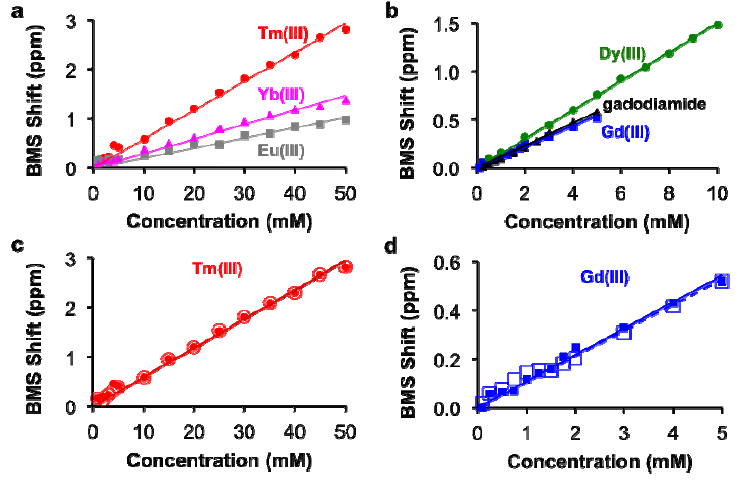
Table 1. Estimates of µ